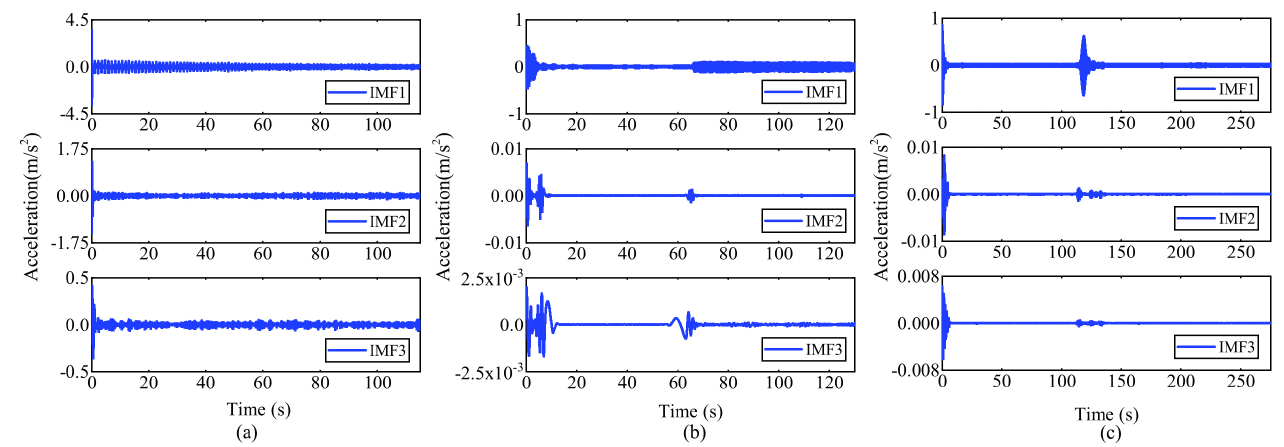
Figure 11. VMD decomposition results of the full-scale model experiment: ( a ) Condition 1, ( b ) Condition 2, ( c ) Condition